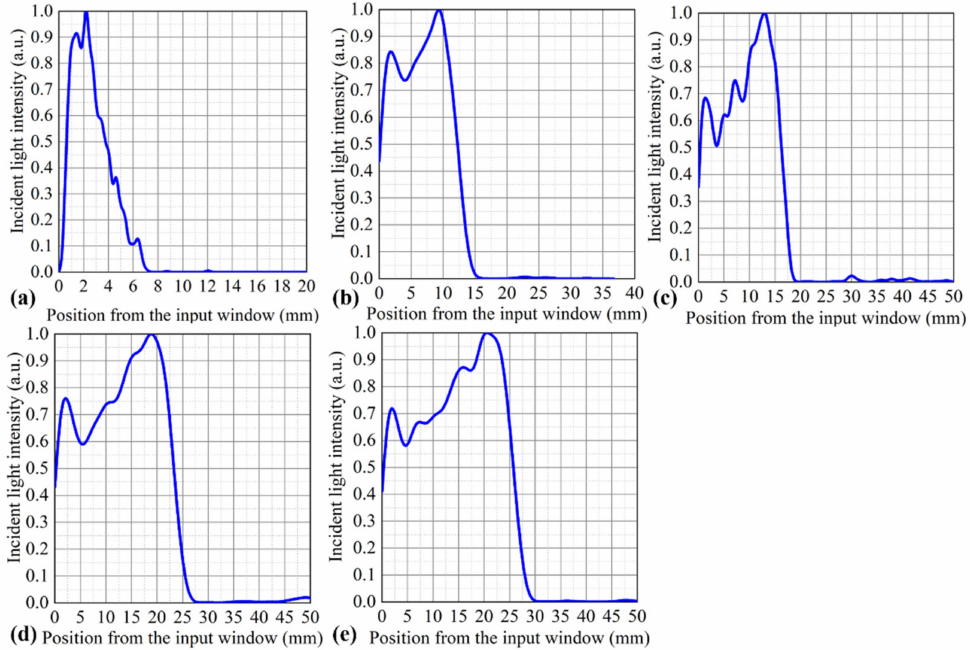
Figure 7. Distributions of incident solar light intensity on the surface of the pump cavity S1 for